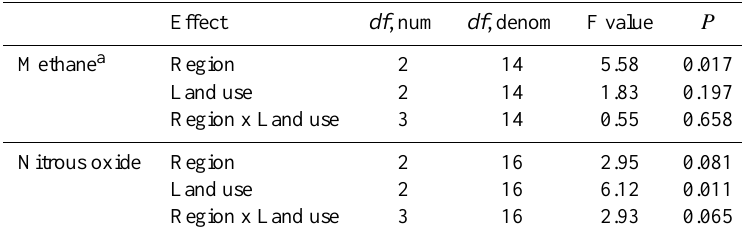
Table 6. Effects of region and land use were evaluated with an approximative linear mixed model (see text). Methane fluxes were square-root transformed, and N 2 O fluxes ln transformed, prior to testing.